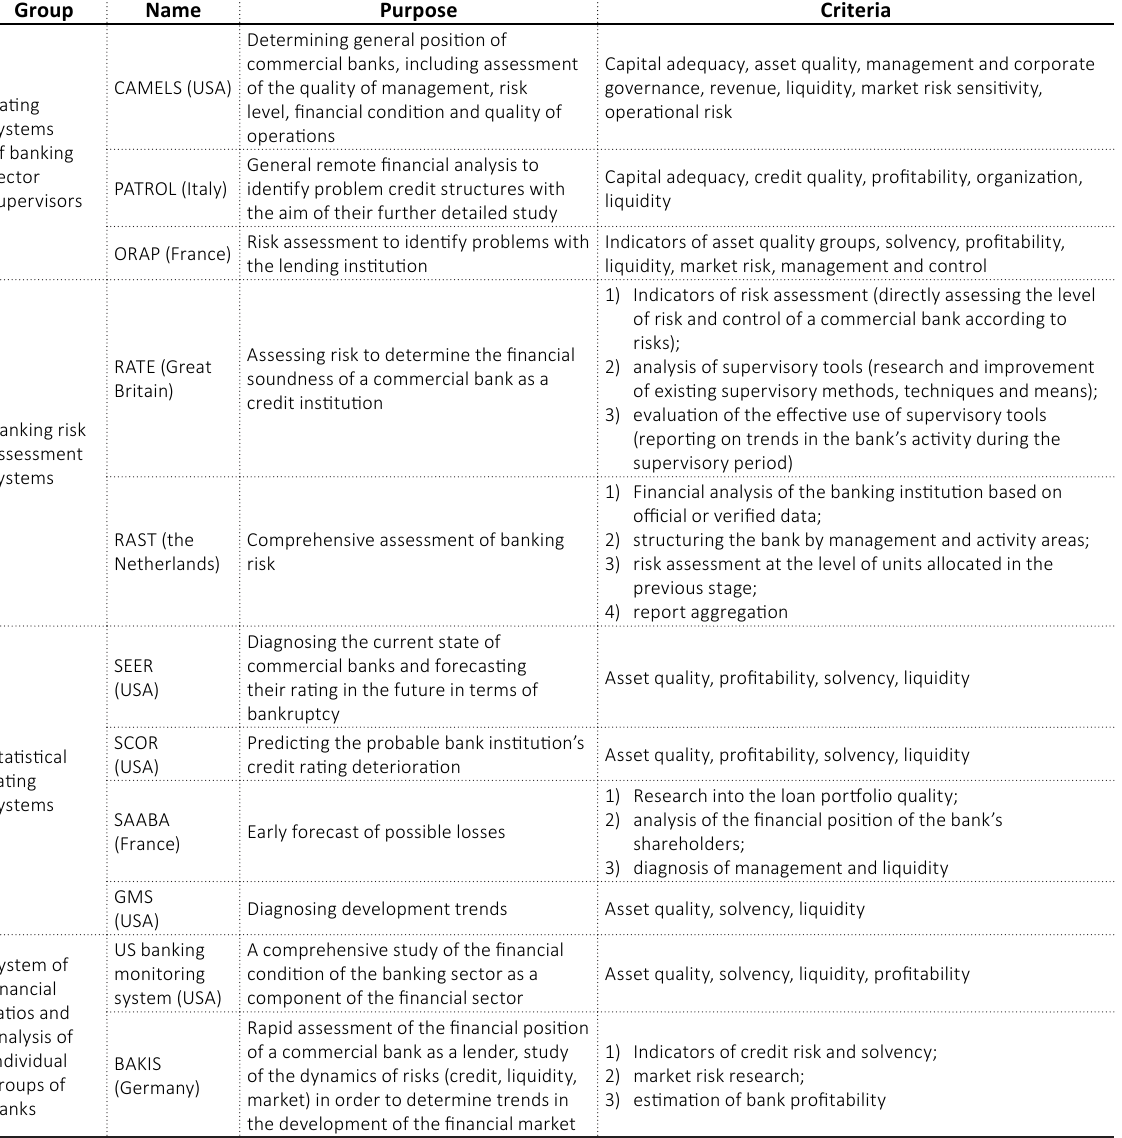
Table 3. Specific features of rating systems for evaluating banking institutions’ performance in the world’s leading